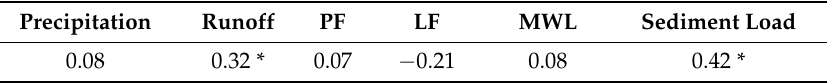
Figure 4. Time series of annual precipitation ( a ), runoff ( b ), PF ( c ), LF ( d ), MWL ( e ), and sediment load ( f ) during the period of 1954–2006 at Jiuzhou Station. Note: Time series of sediment load only cover the period of 1957–2006. Table 2. Correlation coefficients of observed hydrological elements and sediment load at Jiuzhou Station from 1957 to 2006.